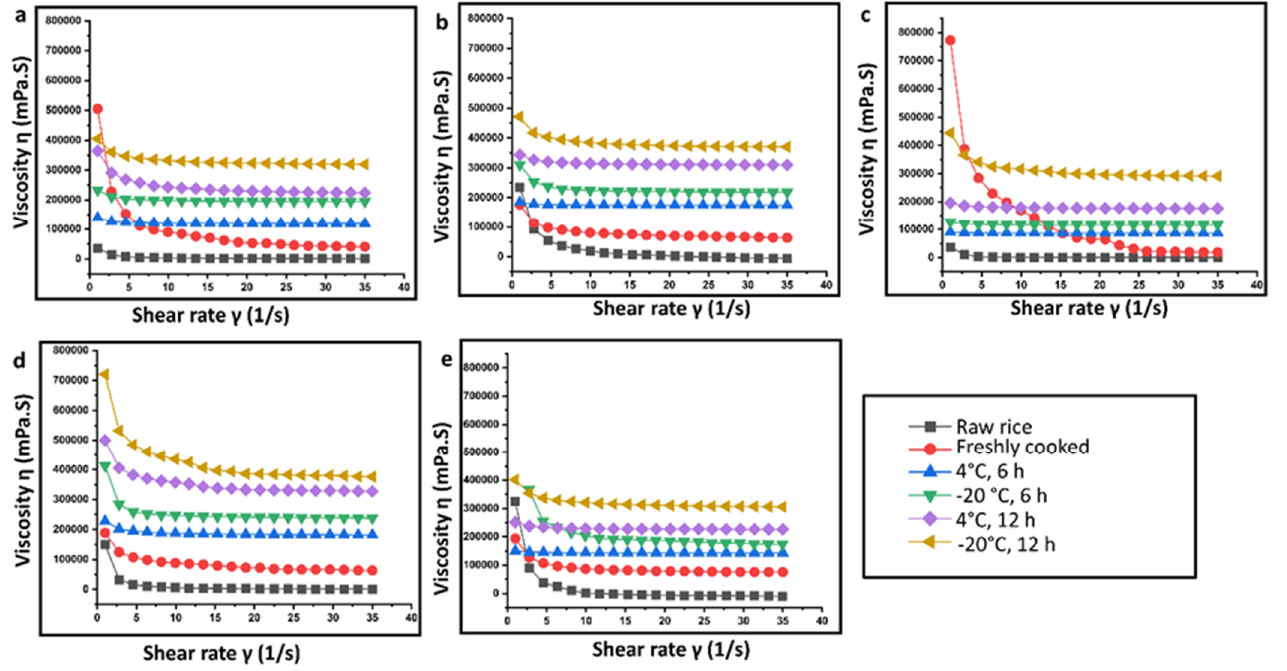
Figure 4. Relationship between apparent viscosity and shearing rate of rice samples subjected to different storage conditions for retrogradation: ( a ) Diasang lahi, ( b ) Khaju lahi, ( c ) Dhusuri bao, ( d ) Omkar, and ( e ) Bili rajamudi .